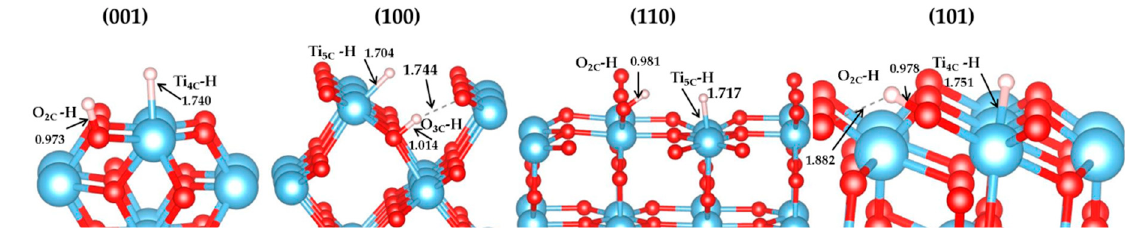
Figure 9. Structures of (H + -H − ) species on (001), (100), (110), and (101) surfaces (bond distance in Å).